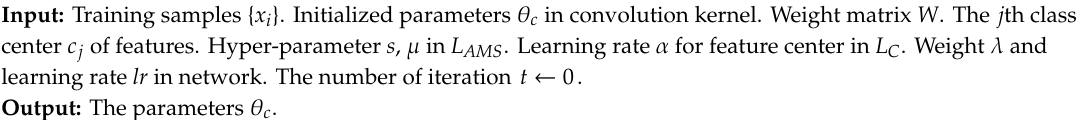
Algorithm 1. The neural network algorithm with convolution module and residual structure